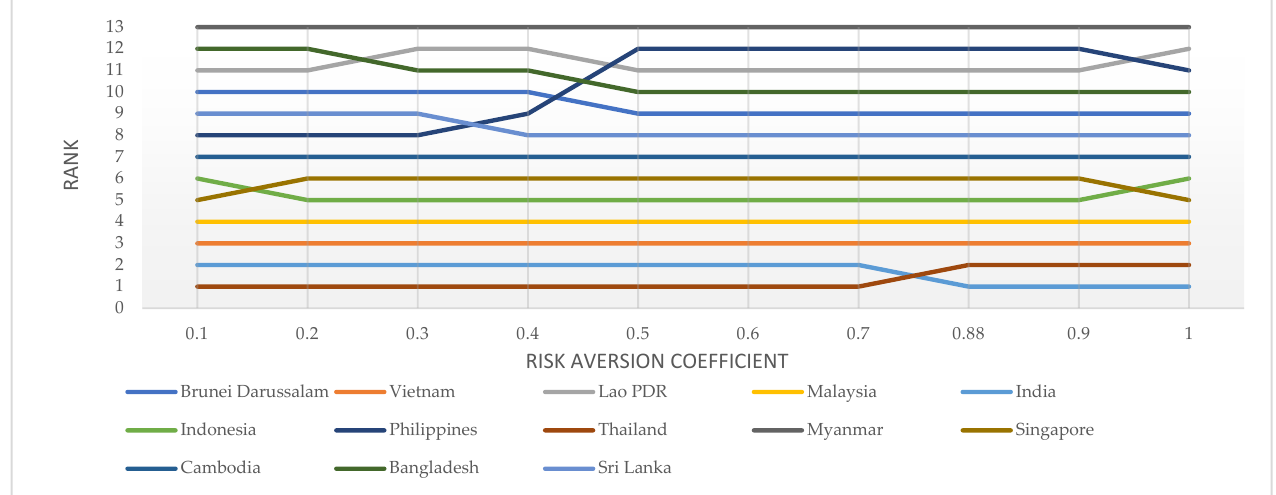
Figure 8. Risk-aversion coefficient sensitivity analysis.